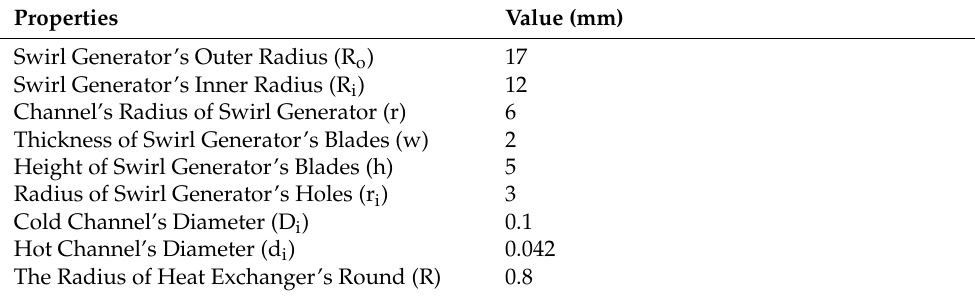
Figure 2. The 3D-views of the employed curved swirl generator and 2D-view of the swirl generator’s cross-section with geometric factors. Table 1. The values of the geometric factors of the computational domain.